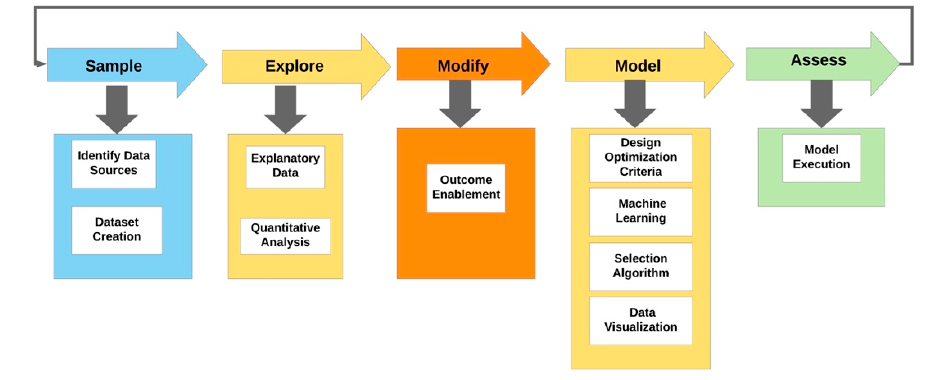
Figure 3. SEMMA methodology (Source: Adapted [27]).